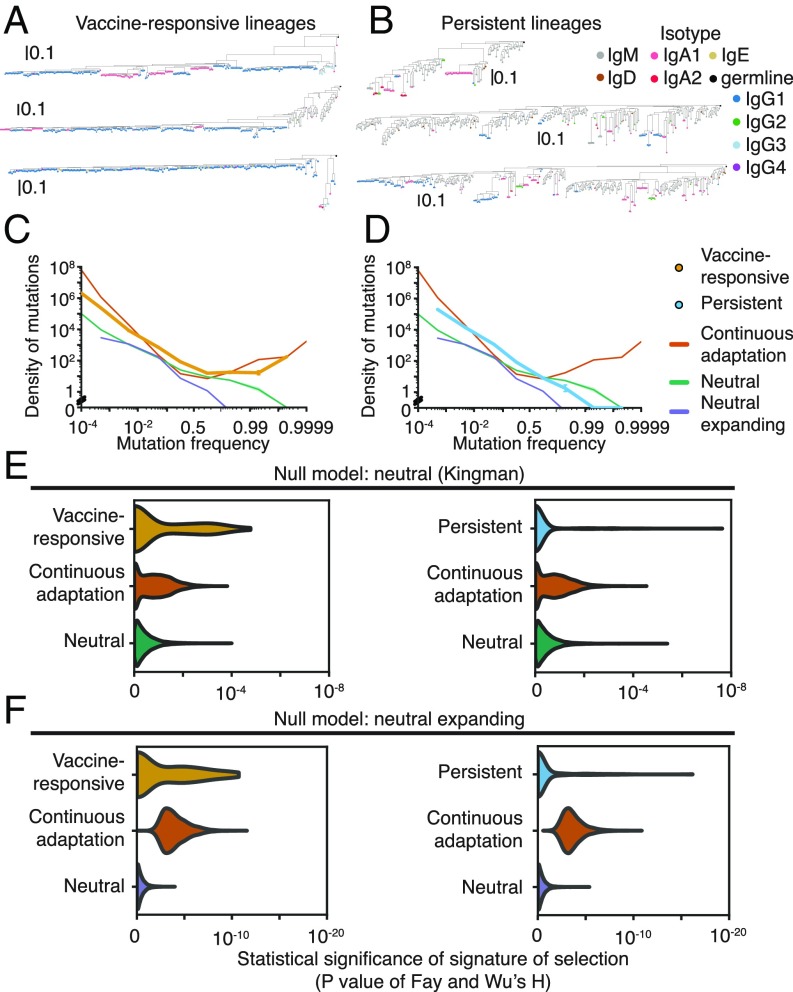
Genetic signatures of somatic evolution in clonal antibody lineages. (A and B) Examples of phylogenies of vaccine-responsive (A) or persistent (B) clonal B cell lineages. Leaves are colored by isotype. Phylogenies are rooted on the germline sequence. (C and D) SFSs averaged across all vaccine-responsive lineages (C) or persistent lineages (D). Error bars indicate SEM. SFSs generated by population genetic models of continuous adaptation driven by strong positive selection (orange), neutral drift with a constant population size (green), and neutral drift with an expanding population (purple) are shown for comparison. Shading indicates SEM across simulations (100 replicates). (E and F) Distribution of significance scores of Fay and Wu’s H statistic for vaccine-responsive lineages or persistent lineages compared against null models of neutral evolution with constant (E) or expanding (F) population size. Distributions for the null models and for simulated populations undergoing continuous adaptation driven by strong selection are also shown. Simulations were performed using population sizes sampled from the observed population-size distributions of vaccine-responsive or persistent lineages (10,000 replicates).